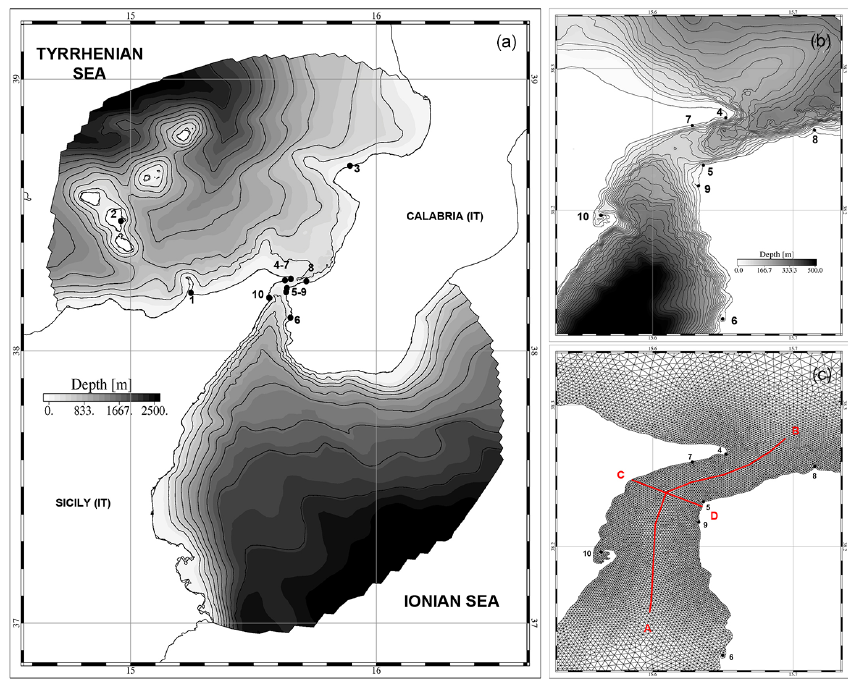
Figure 1. (a) Geographical settings and model domain: investigated area comprising the Messina Strait, the southern Tyrrhenian Sea and part of Ionian Sea; geometry and bathymetry. Black dots and numbers indicate the tide gauge locations at Milazzo (1), Lipari (2) Tropea (3), Faro (4), Punta Pezzo (5), Reggio (6), Messina (7), Ganzirri (8), Villa S. Giovanni (9) and Messina (10). (b) Zoom of the Messina Strait. (c) Zoom of the finite element mesh adopted for numerical simulations. Red lines from A to B and from C to D indicate the sections used for the flux computation and model results